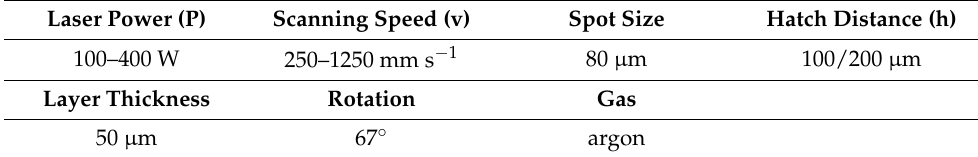
Table 1. LPBF (laser powder bed fusion) process